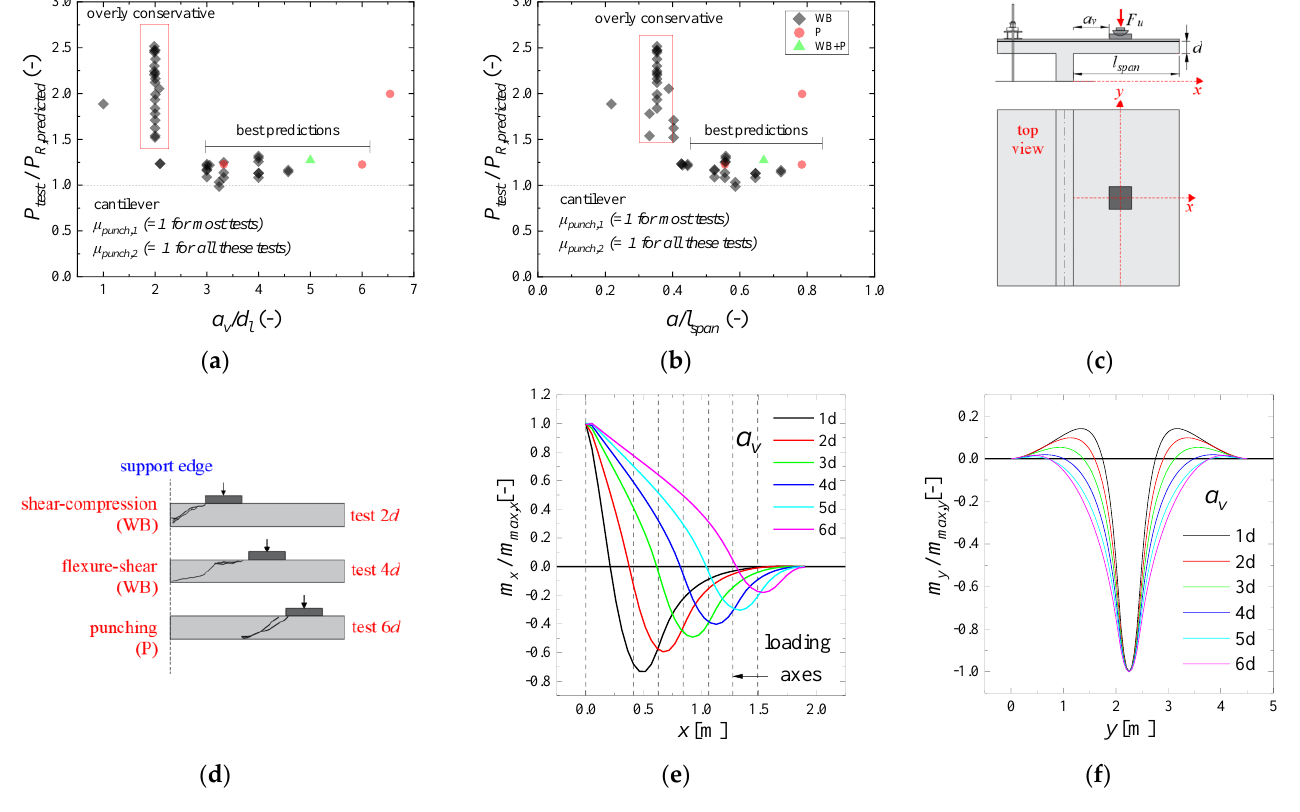
Figure 16. ( a ) Comparison between tested and predicted resistances with the punching capacity expressions from the Eurocode for cantilever slabs as function of the shear slenderness a v / d l ; and ( b ) as function of the ratio a / l span ; ( c ) sketch of the tests performed by Henze et al. [7] on cantilever slabs; ( d ) cracking pattern of the tests performed by Henze et al. [7] (cut views); ( e ) distribution in the bending moments in the axis of symmetry of the slabs (axis x ); ( f ) distribution in the bending moments in the transverse direction of the slabs (axis y). Table 4. Factor ( μ punch,3 ) related to the ratio a / l span .